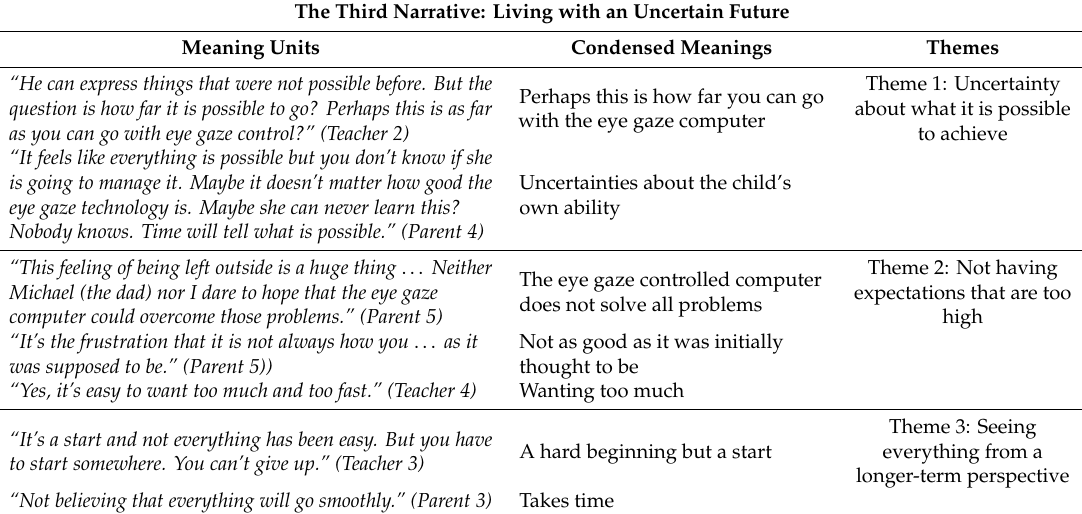
Themes and examples of connected meaning units and condensed meaning in the third